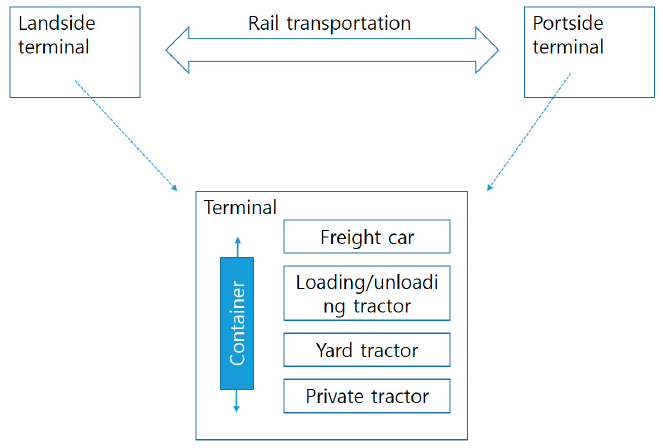
Figure 1. Conceptual diagram of the automated container transport system (ACTS).